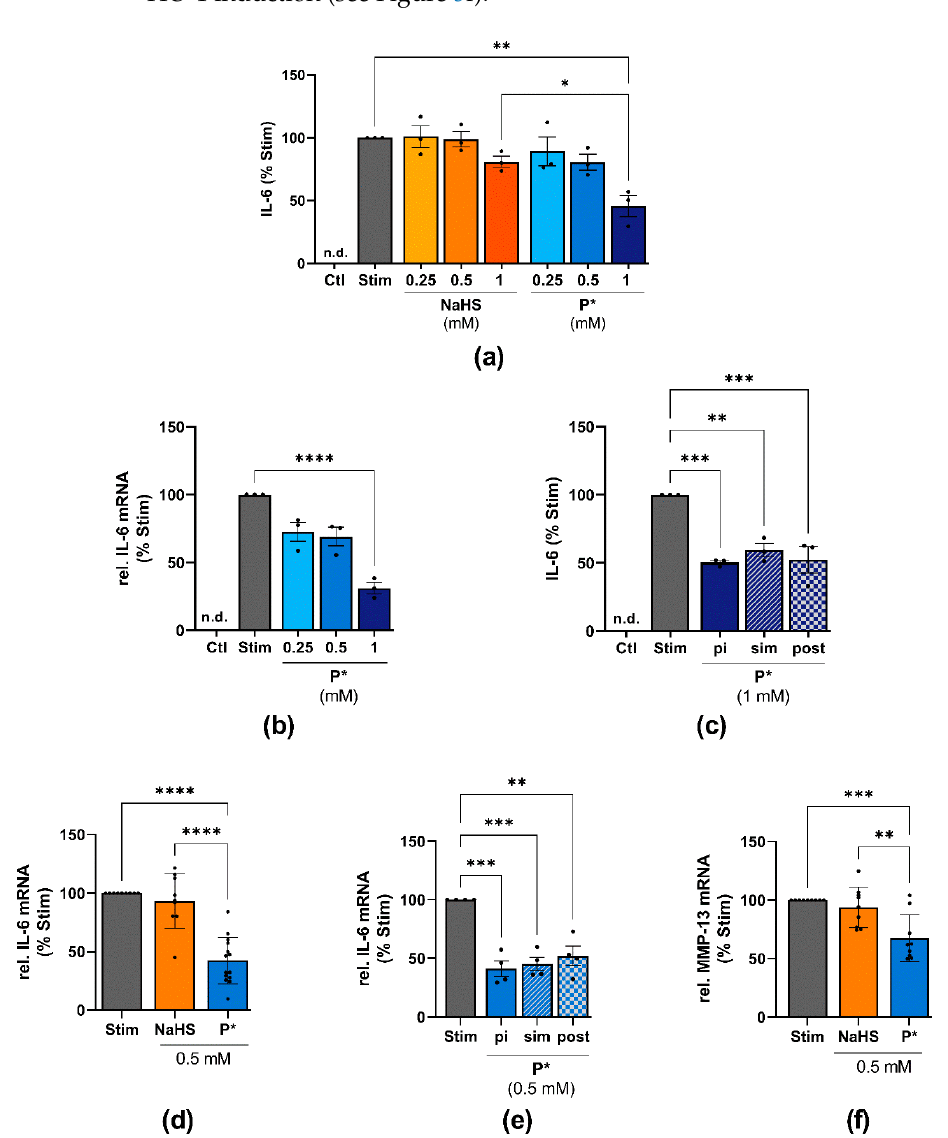
Figure 7. Effects of P* on IL-6 expression in ATDC5 cells and primary human chondrocytes. Ctl = untreated cells, n.d. = non-detected; significance is only shown for the highest concentrations used. ( a ) ATDC5 cells were treated with the indicated concentrations of NaHS or P* for 1 h followed by 24 h of stimulation with IL-1 β /IFN- γ . IL-6 levels were assessed by ELISA and normalized to stimulated cells (Stim) set to 100%, n = 3, * p < 0.05, ** p < 0.01. ( b ) ATDC5 cells were incubated with P* for 1 h and stimulated for 24 h. IL-6 mRNA levels were determined by qPCR with cyclophilin D as a reference gene and normalized to Stim set to 100%, n = 3, **** p < 0.0001. ( c ) ATDC5 cells were incubated with 1 mM P* 1 h before (pi), simultaneously (sim), or 1 h after (post) 24 h of stimulation with IL-1 β /IFN- γ . IL-6 levels were assessed by ELISA and normalized to Stim (100%), n = 3, ** p < 0.01, *** p < 0.001. ( d ) Primary human chondrocytes from OA patients were preincubated for 1 h with 0.5 mM NaHS or P* and stimulated for 24 h with IL-1 β . IL-6 mRNA levels were determined by qPCR with SDHA as a reference gene and normalized to Stim (100%). NaHS: n = 9, P*: n = 14, **** p < 0.0001. ( e ) Primary human chondrocytes from OA patients were incubated with 0.5 mM P* 1 h pi, sim, or post 24 h of stimulation with IL-1 β . mRNA levels were determined by qPCR with SDHA as a reference gene and normalized to Stim (100%), n = 4, ** p < 0.01, *** p < 0.001. ( f ) Primary human chondrocytes from OA patients were preincubated for 1 h with 0.5 mM NaHS or P* and stimulated for 24 h with IL-1 β . MMP-13 mRNA levels were determined by qPCR with SDHA as a reference gene and normalized to Stim set to 100%, n = 9, ** p < 0.01, *** p < 0.001.